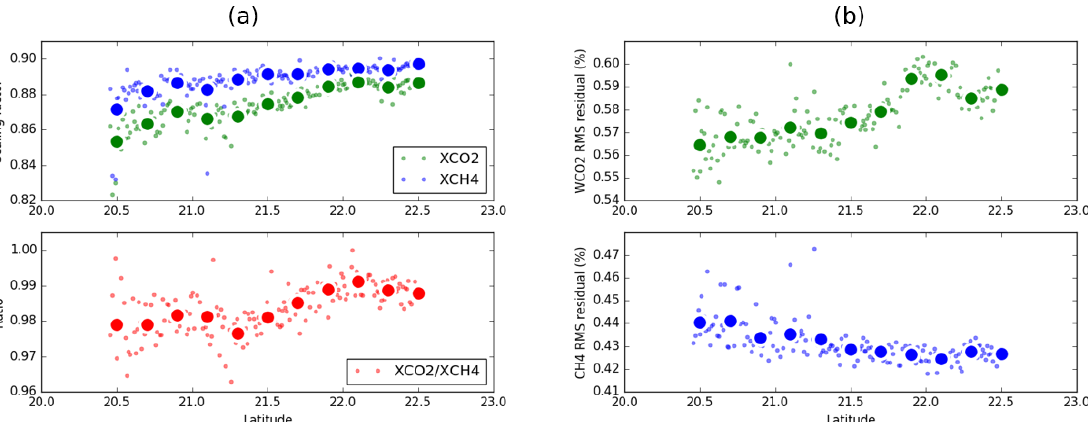
Figure 21. (a) Scatter plots for the Band 2A retrieved XCO 2 (green) and XCH 4 (blue) scaling factors, along with the ratios (red), from spectra measured during the OCO-2 overpass of the 10 March 2015 Global Hawk flight. (b) Scatter plot of rms residual for the Band 2A CO 2 (green) and CH 4 (blue) fit windows. The data are averaged into 0 . 2 ◦ latitude bins (the average for each bin is indicated by the larger